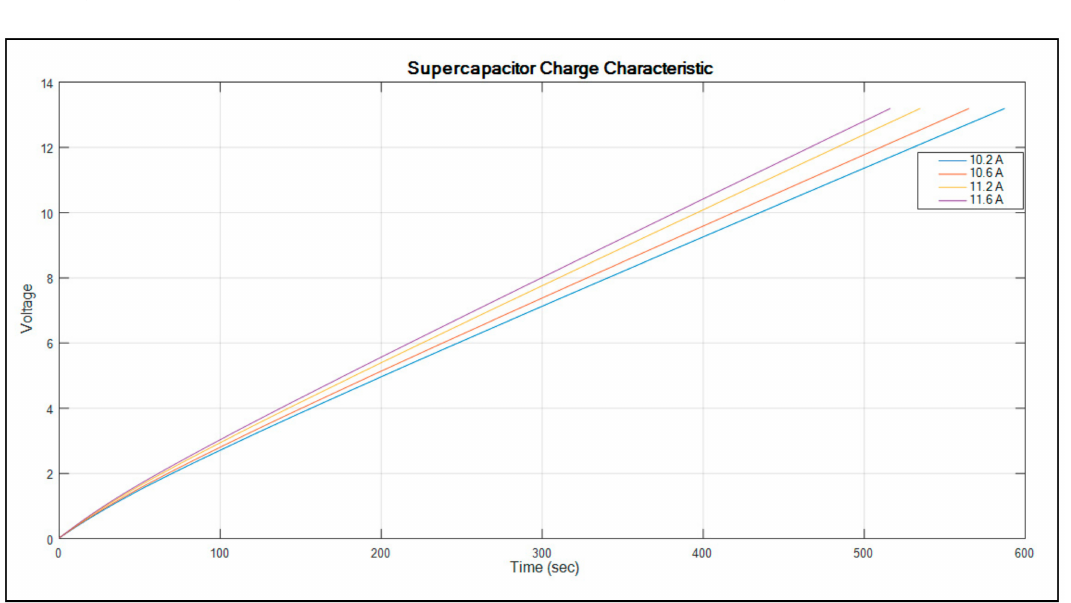
Figure 7. Supercapacitor charge characteristics at 10.2